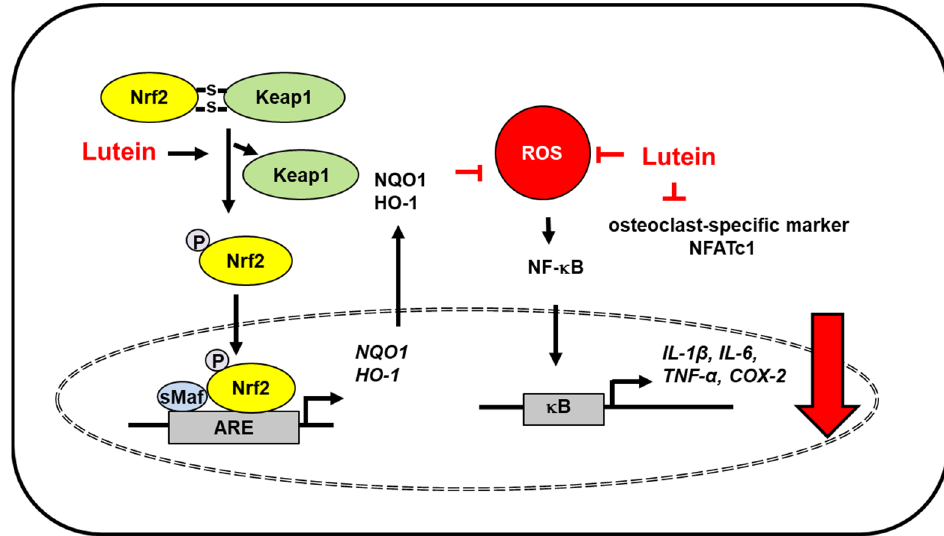
Figure 3. The proposed mechanism by which lutein inhibits oxidative stress-induced inflammatory responses in bone. ROS levels increase in monosodium iodoacetate-induced osteoarthritis in primary chondrocyte cells and femur tissues of ovariectomized rats (osteoporosis model). Lutein reduces ROS levels and inhibits ROS-mediated activation of NF-kB and the expression of inflammatory mediators (IL-1 β , IL-6, TNF- α , COX-2). Moreover, lutein increases dissociation of Keap1 from Nfr2/Keap1 complex and thus, promotes nuclear translocation of Nrf2, which forms a heterodimer with sMaf protein and binds to the regulatory region of DNA called ARE. It induces the expression of Nrf2- target antioxidant genes (HO-1, NQO1). These antioxidant enzymes reduce intracellular ROS levels, which suppresses inflammatory responses [58,59]. In addition, lutein inhibits osteoclast-specific marker NFATc1 in the bone of ovariectomized rats [59]. Thus, lutein prevents oxidative stress-mediated osteoarthritis and bone deterioration. ARE, antioxidant response element; COX-2, cyclooxygenase-2; HO-1, hemeoxygenase-1; IL, interleukin; Keap1, kelch like ECH associated protein 1; NF − κ B, nuclear factor- κ B; Nrf2, nuclear factor erythroid 2–related factor 2; NQO-1, NAD(P)H:quinone oxidoreductase 1; NFATc1, nuclear factor of activated T